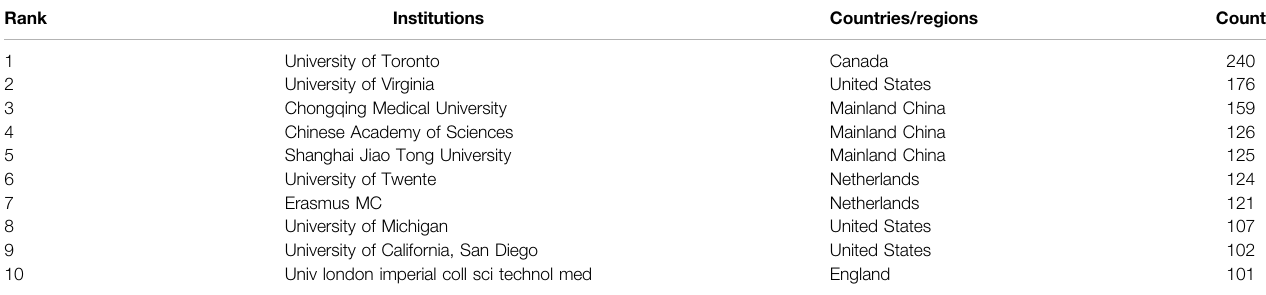
TABLE 1 | Top 10 institutes that contributed to publications about ultrasound